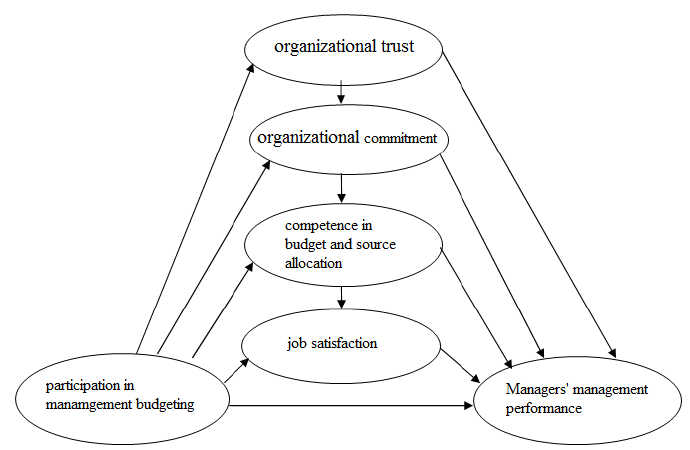
Fig. 1. Conceptual model of research adopted from Sugioko model